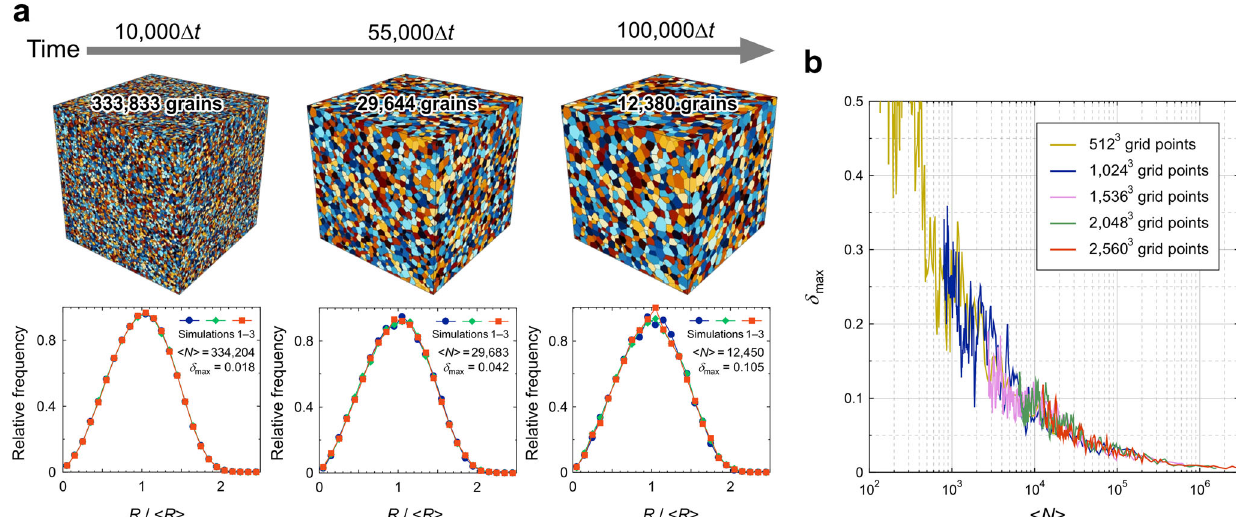
Fig. 1 Evaluation of the statistical reliability of calculated grain size distributions. a Top : evolved microstructures obtained for a 2560 3 -point system at different time periods. Grains are distinguished by different colors. Bottom : grain size distributions calculated from three replicated simulations for 2560 3 -point systems for times corresponding to the upper row. b Maximum difference as a function of the average number of remaining grains in three simulations, calculated for different domain